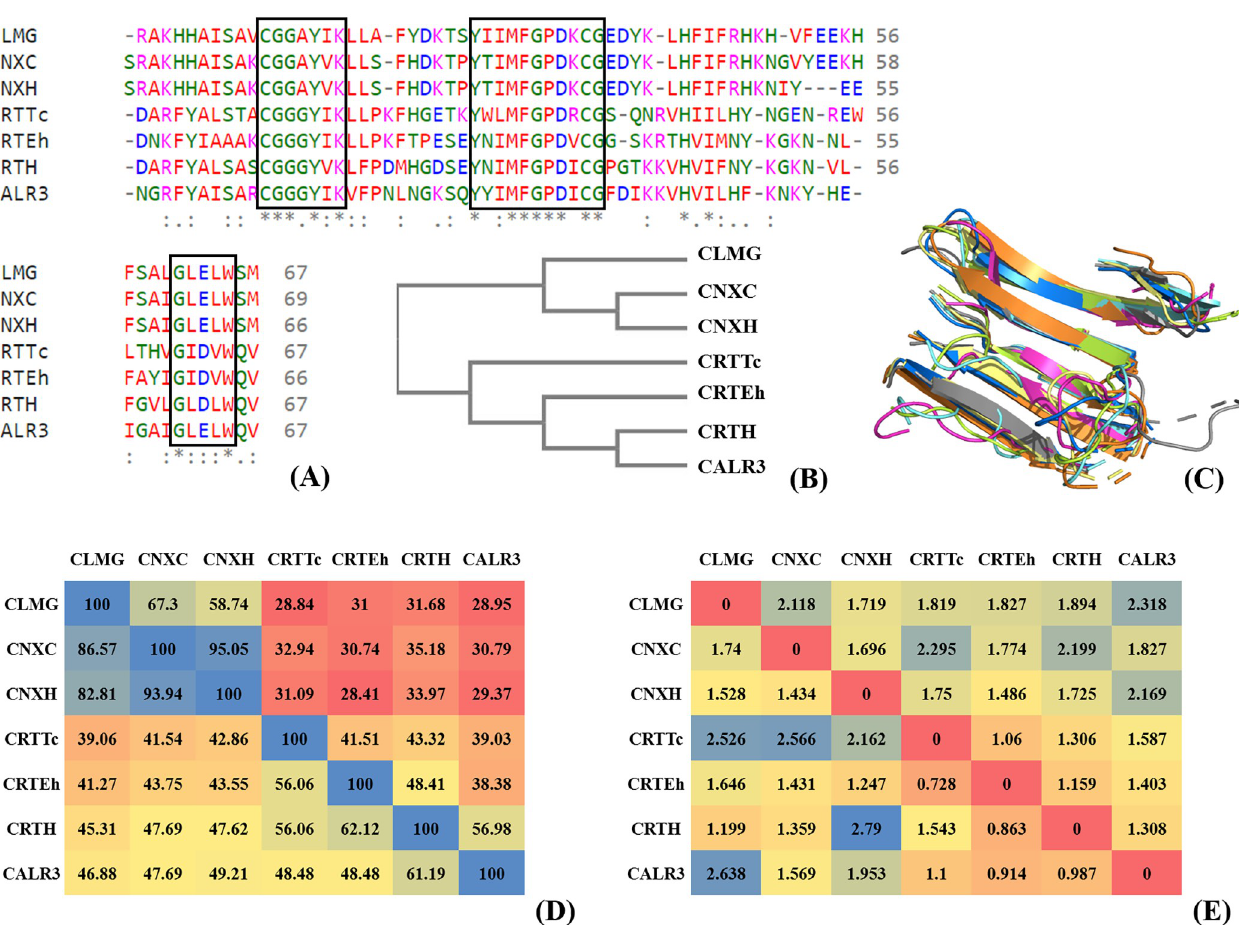
Fig 1. Sequence and structure alignment of carbohydrate recognition domain (CRD) residues of the seven calreticulin family of proteins. (A) Multiple sequence alignment of calnexin in dog (CNXC), human (CNXH), its homolog in testis—calmegin (CLMG), calreticulin in human (CRTH), Entamoeba histolytica (CRTEh), Trypanosoma cruzi (CRTTc) and its homolog in testis—calsperin (CALR3); (B) Phylogenetic tree showing the relationship between the calnexin and calreticulin and its homologs; (C) Superposition of the CRD region of proteins; (D) Heatmap showing the similarity of the aminoacids sequence– upper diagonal represent the whole sequence and lower diagonal for CRD residues; and (E) Heatmap of the root mean square deviation of the protein structures–upper diagonal represent structural deviation in whole proteins and lower diagonal for the CRD region only.